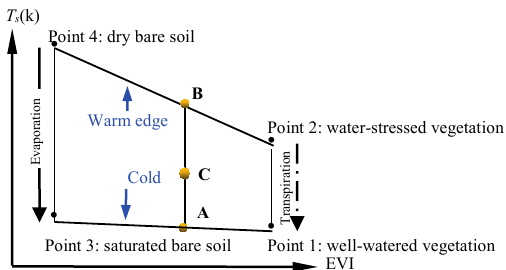
Fig. 1 Structure of the Ts–VI trapezoidal space with four vertexes representing four extreme conditions (i.e. well-watered vegetation, water-stressed vegetation, saturated bare soil and dry bare